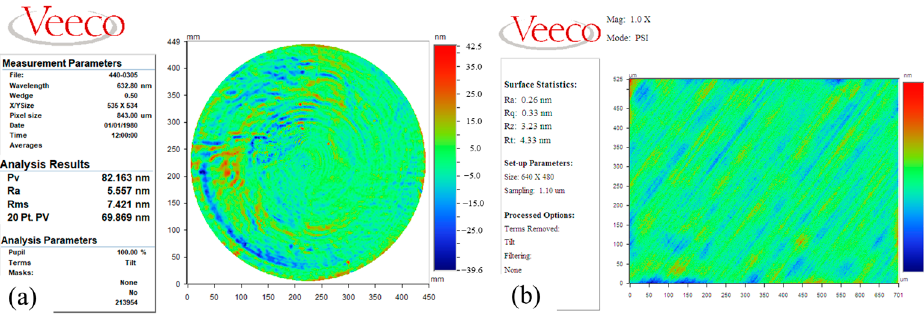
Figure 25. Result of the SiC aspheric mirror after MRF. ( a ) Wavefront; ( b ) surface roughness.